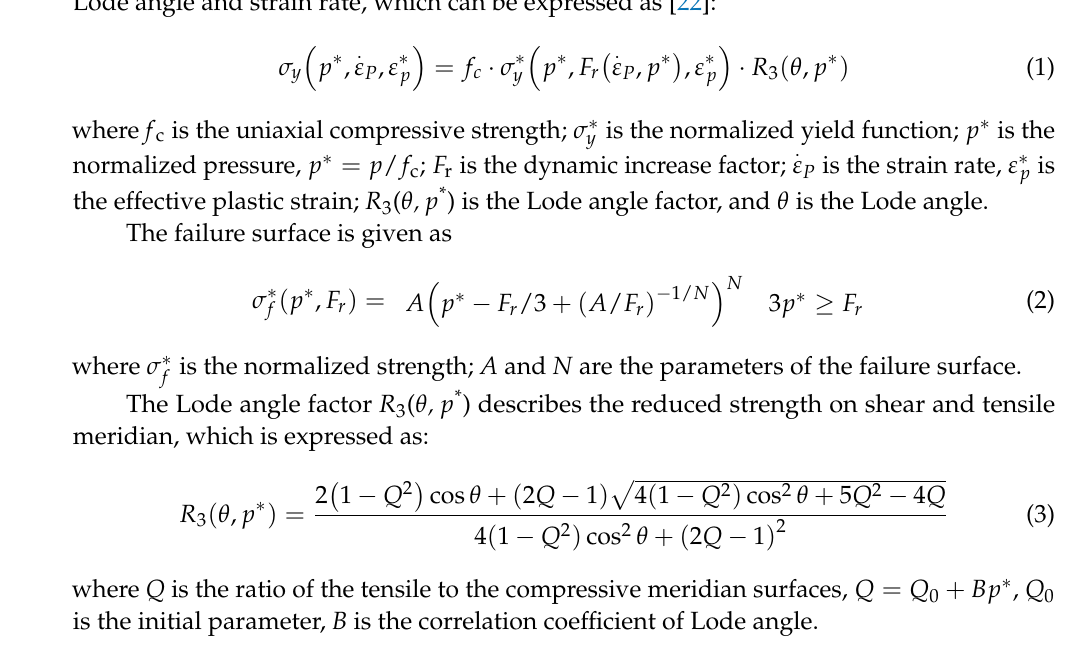
Figure 1. The RHT model: ( a ) p ‐α equation of state; ( b ) stress limit surfaces and loading scenario. The yield surface of the RHT model is described as a function of normalized pressure, Lode angle and strain rate, which can be expressed as